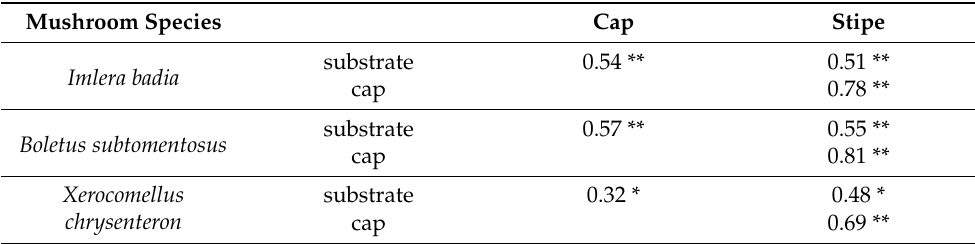
Table 3. Spearman’s correlation relationships between the substrate and the body parts (cap, stipe) Hg content of three different mushrooms